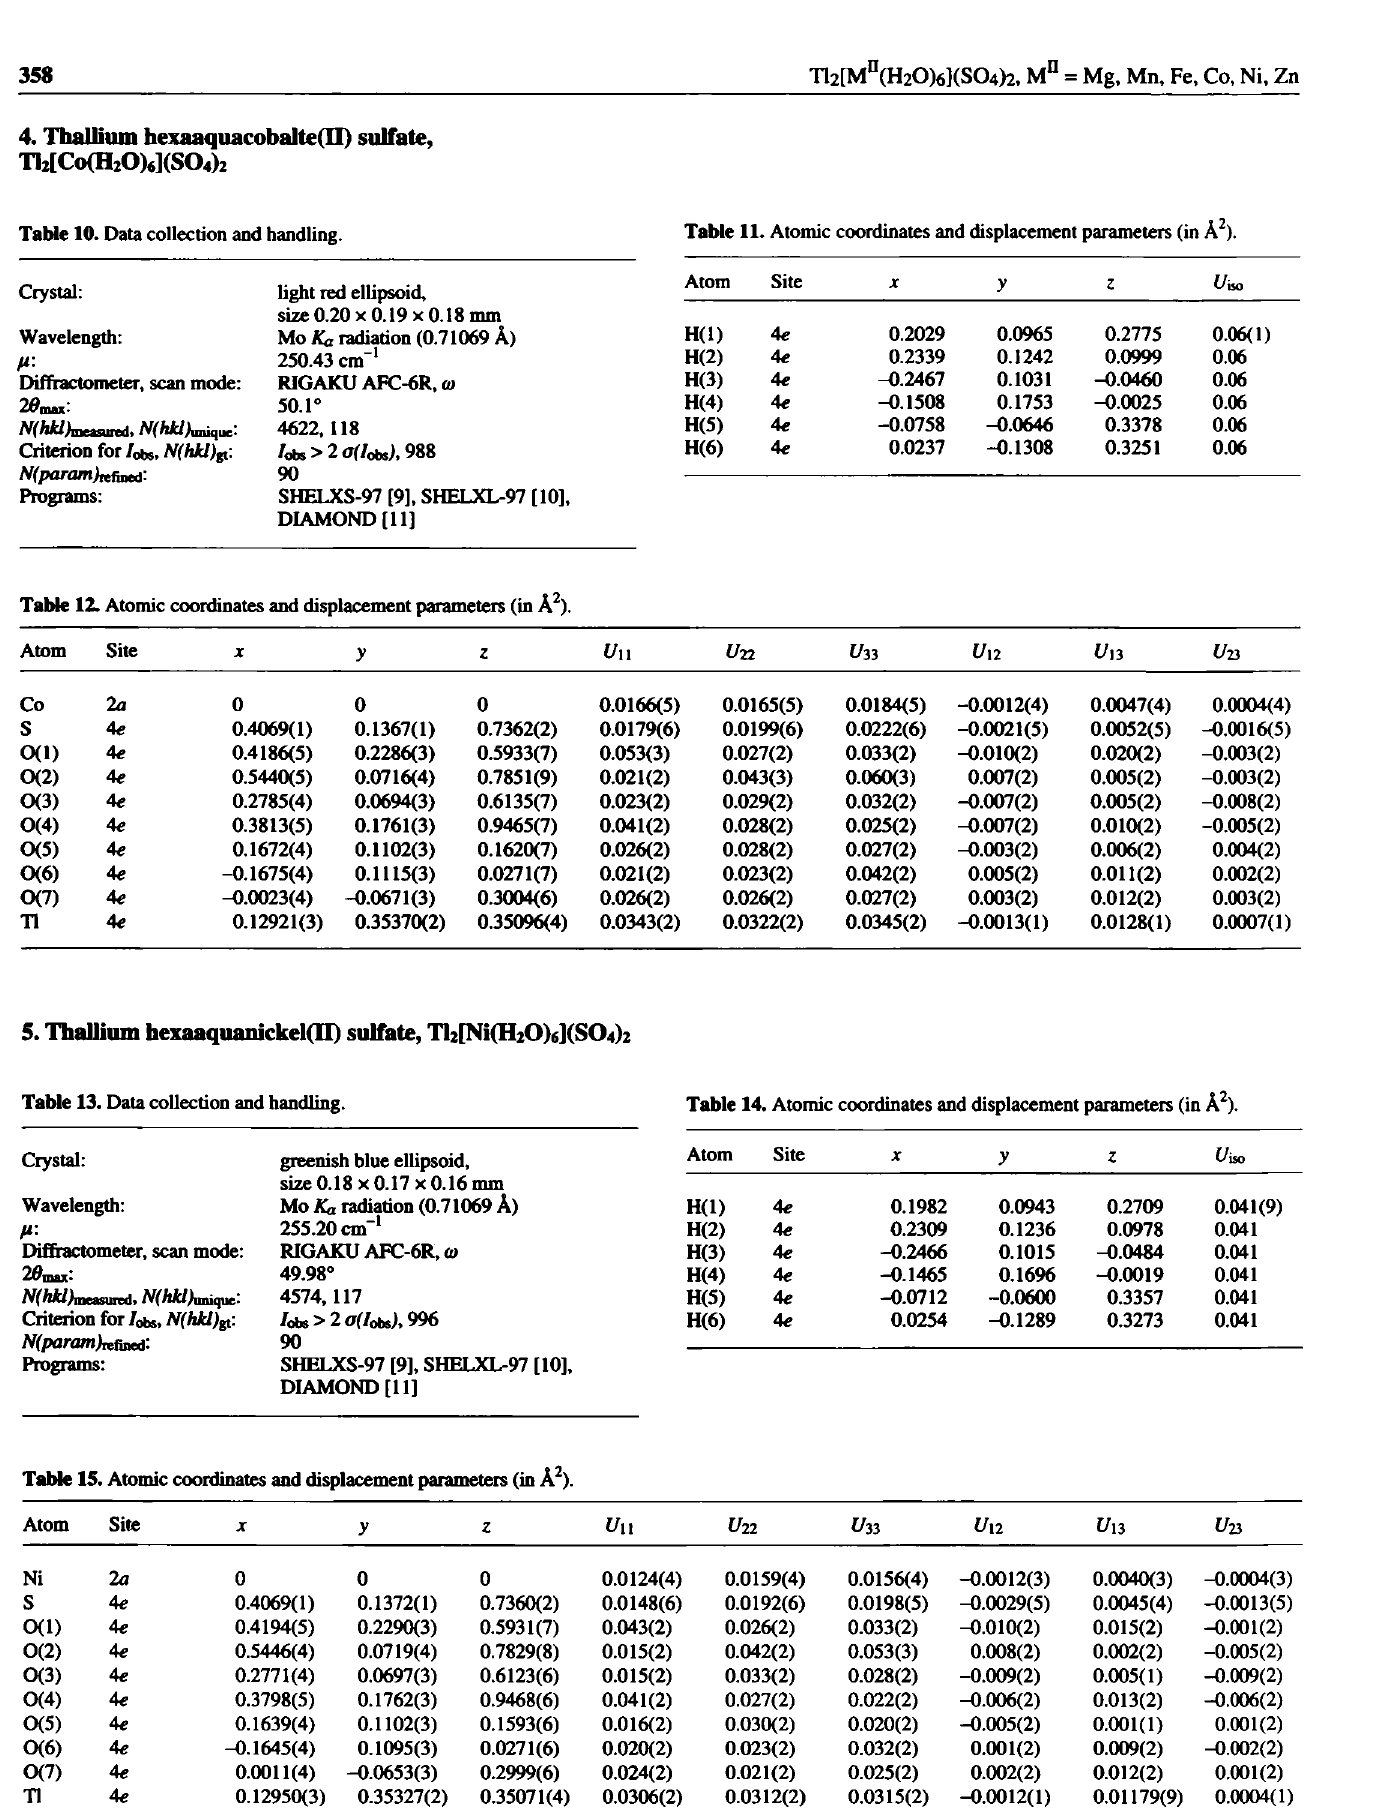
Table 15. Atomic coordinates and displacement parameters (in Â 2